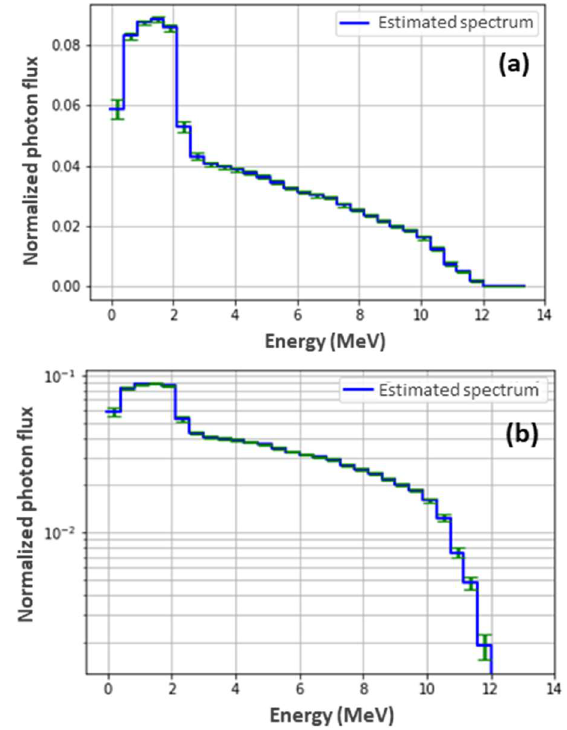
Fig. 11. Estimated mean energy spectrum, in linear (a) and logarithmic (b) scales, from the experimental transmission curve obtained with the SATURNE accelerator, with the green error bars representing the uncertainty of each channel. For each channel, the uncertainty is represented by the green error bars in Fig. 11. The average uncertainty per channel with respect to the average spectrum is 7.1.10 -4 (defined by (5)).